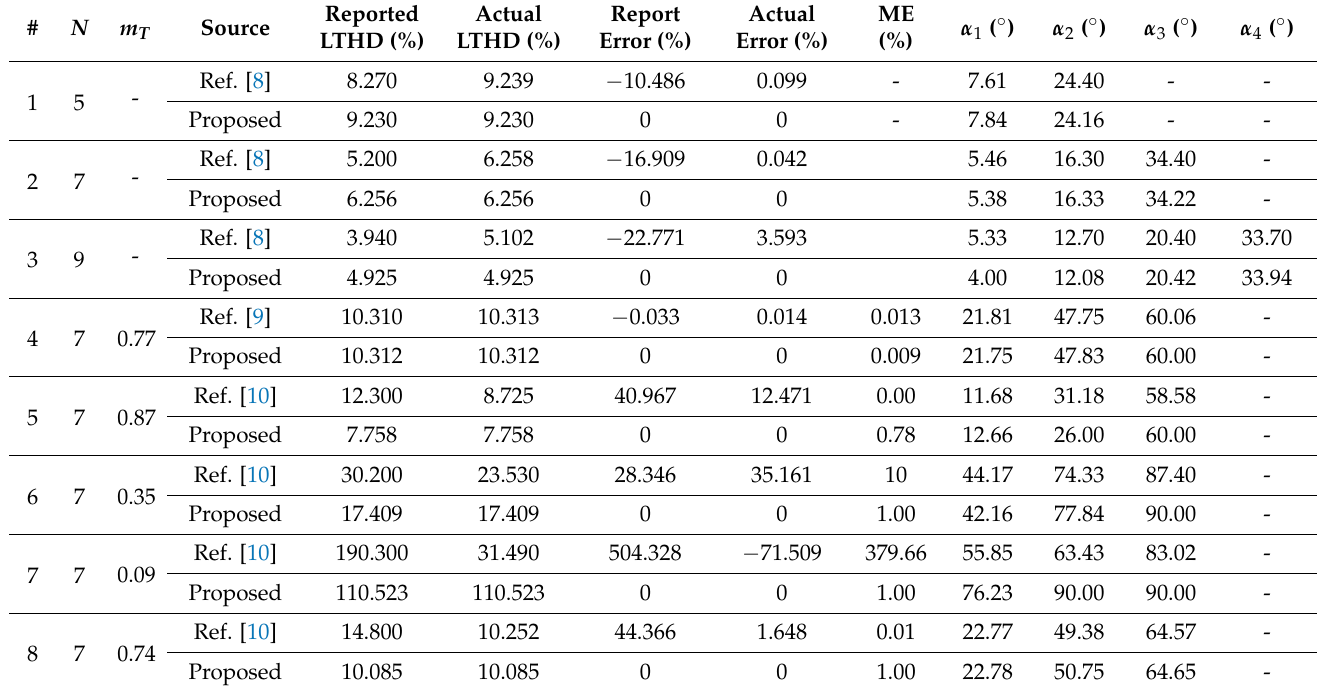
Table 3. Optimal LTHD calculations: comparison between proposed and previously claimed by other